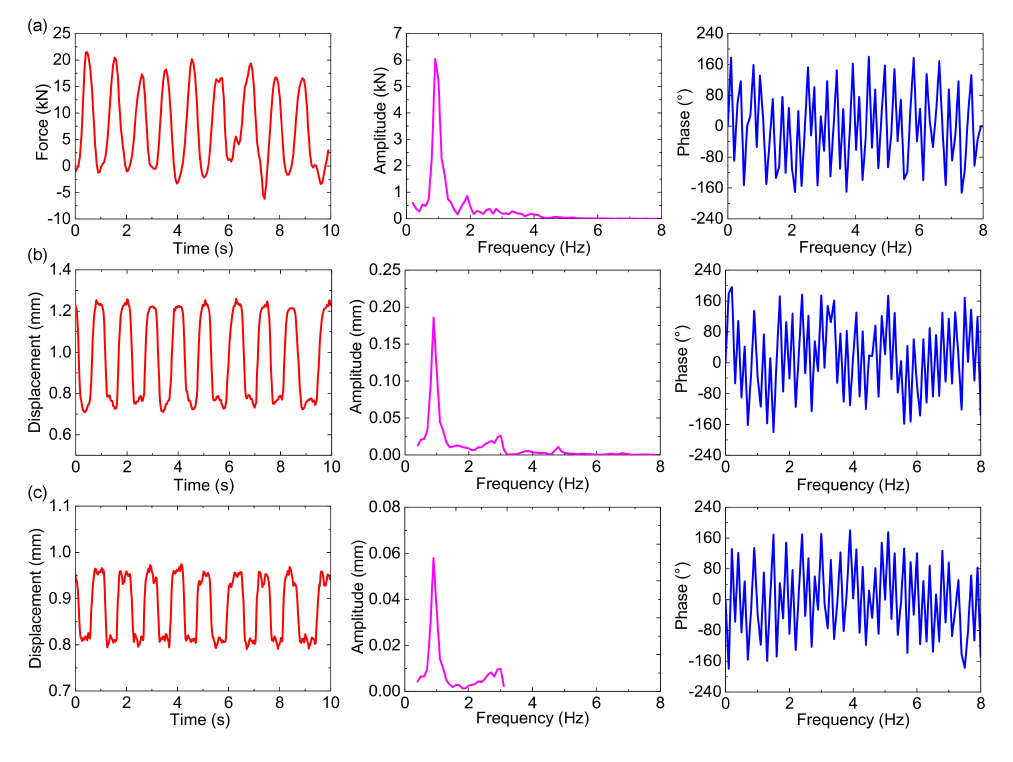
Figure 8. Time and frequency domain diagrams of vertical excitation and response: ( a ) Vertical excitation force; ( b ) vertical displacement on the left side; ( c ) vertical displacement on the right side.